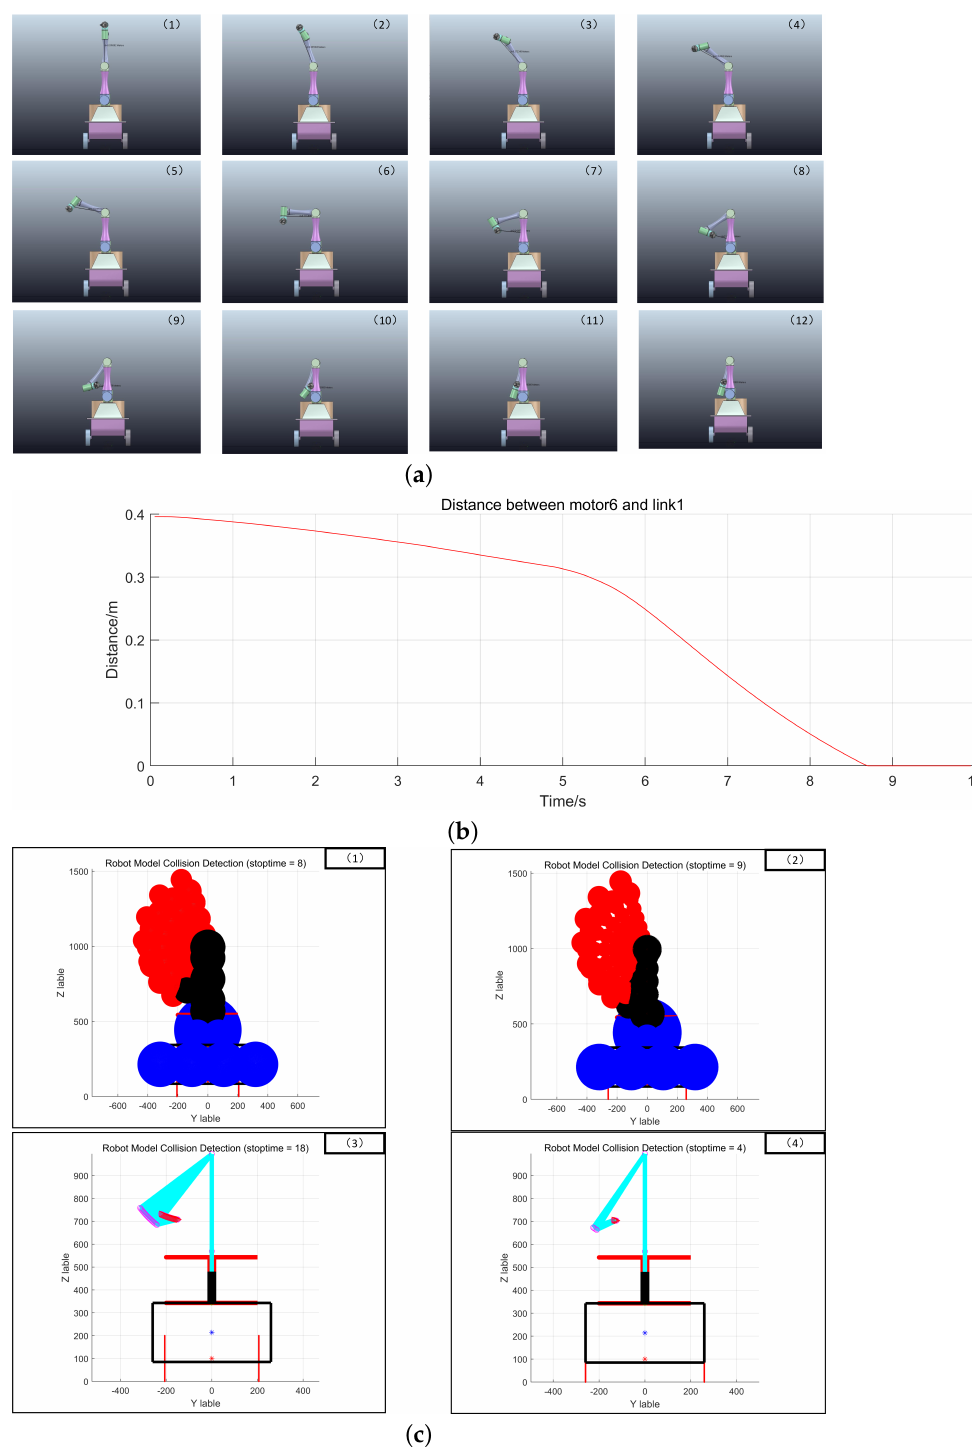
Figure 9. Detection of self-collision between different components of the manipulator subsystem. ( a ) The movement of the mobile manipulator in situation 1 based on the VREP software; ( a1 – a9 ) The movement of the mobile manipulator before reaching collision location in situation 1 based on the VREP software; ( a10 – a12 ) The movement of the mobile manipulator after reaching collision location in situation 1 based on the VREP software; ( b ) Distance changes between two components of the manipulator subsystem; ( c1 ) Detection of self-collision using the typical method; ( c2 ) Detection of self-collision using the improved method; ( c3 ) Simplify the detection of self-collision using the typical method; ( c4 ) Simplify the detection of self-collision using the improved